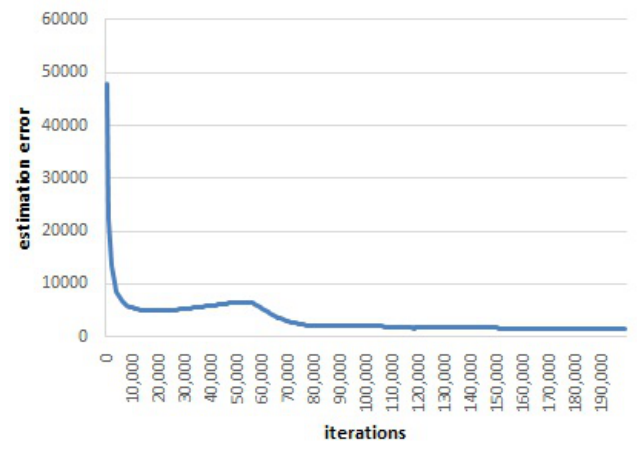
Figure 7. Estimation error versus the number of iterations.